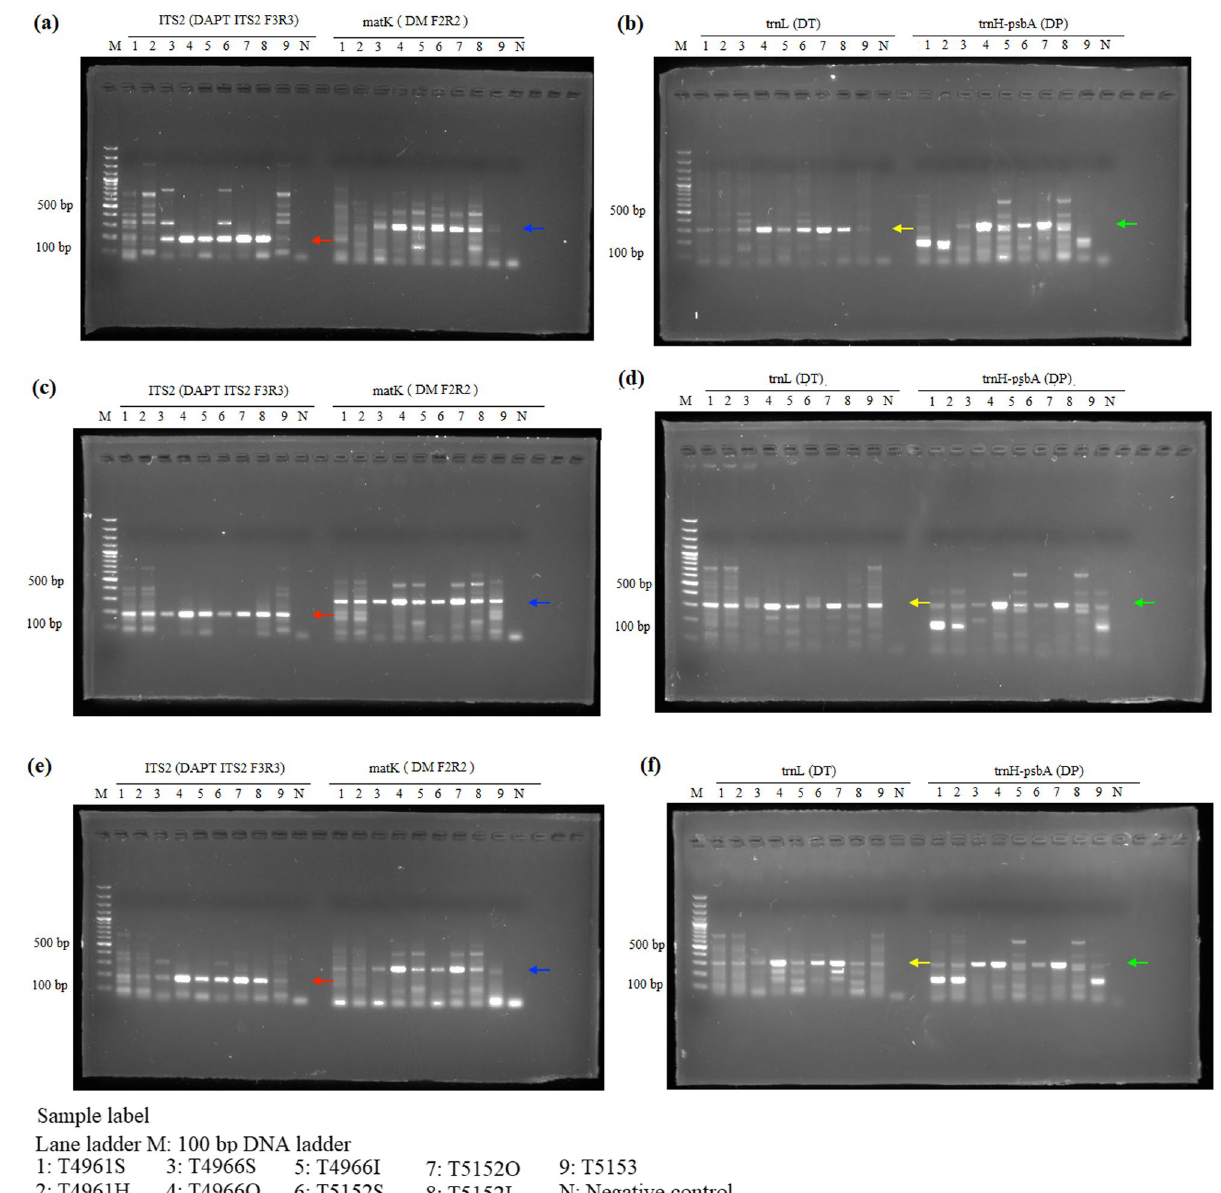
Figure 3. Gel electrophoresis of PCR amplification results of Dalbergia authentic wood samples using different extraction methods, ( a , b ) SDS-based method, ( c , d ) QIAGEN method, and ( e , f ) CCDB method. Red arrows indicate the amplicons of ITS2 (180 bp). Blue arrows indicate the amplicons of matK (300 bp). Yellow arrows indicate the amplicons of trnL region (314 bp). Green arrows indicate the amplicons of trnH - psbA (334